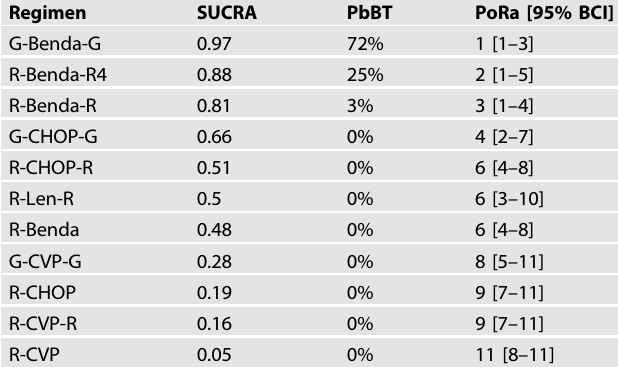
Table 2. Ranking of immunochemotherapy regimens by PFS.